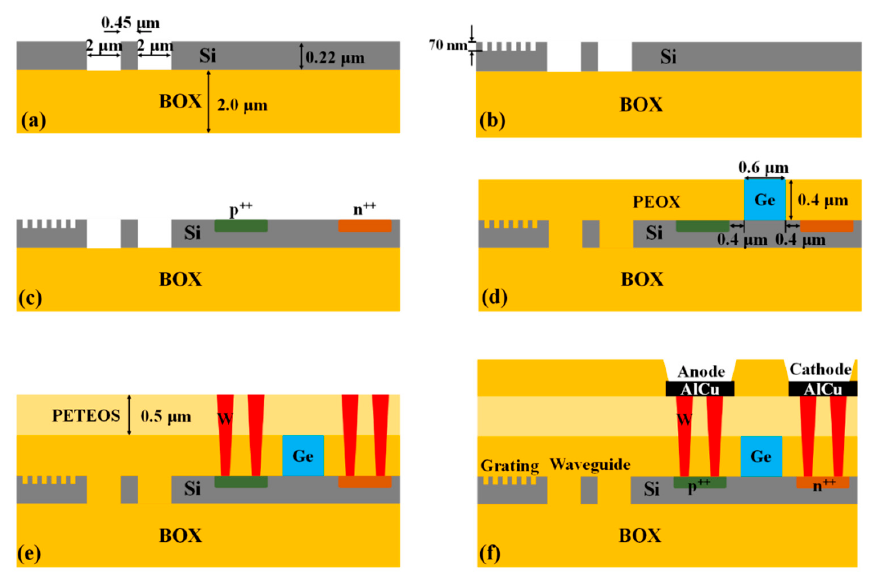
Figure 2. The key processes for waveguide-integrated SAM Ge/Si APD. ( a ) Fabrication of the channel waveguide; ( b ) Fabrication of the grating; ( c ) P-type and N-type implantation for Ohm- contact; ( d ) Selective epitaxial growth of germanium; ( e ) Formation of tungsten plugs; ( f ) Metal deposition, patterning and device passivation.